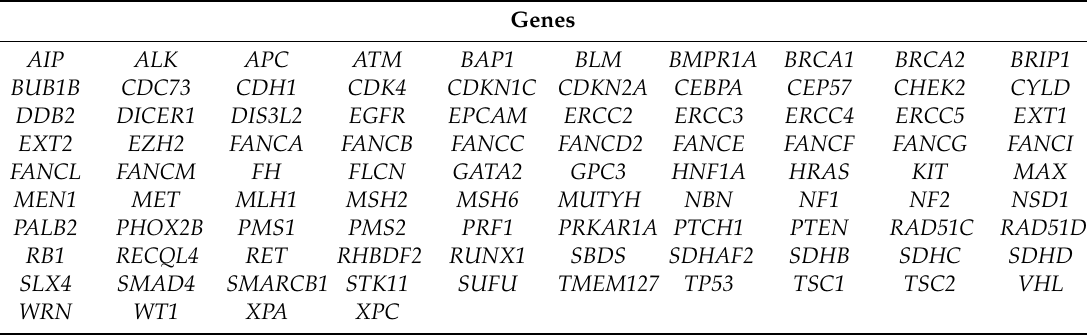
Table 1. List of the 94 cancer predisposition genes included in the Trusight Cancer